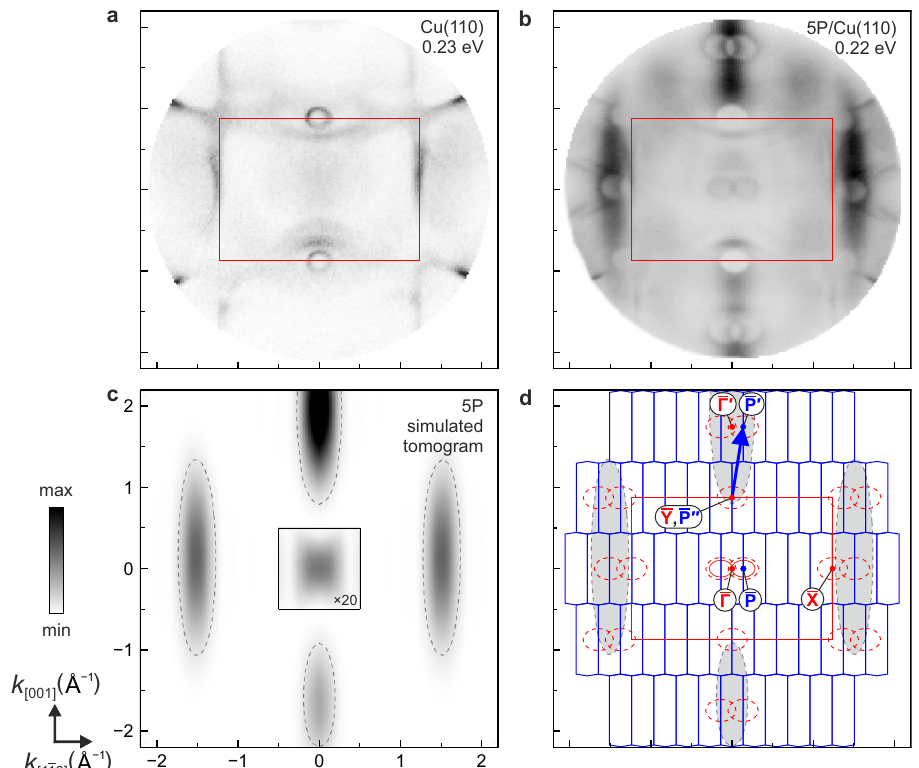
Fig. 2 | Momentum maps of clean Cu(110) and para-quinquephenyl molecules (5P) on Cu(110). a Experimental momentum map of clean Cu(110) at 0.23 eV binding energy. b Experimental momentum map of 5P/Cu(110) at 0.22 eV binding energy. The experimental momentum maps in panels a and b correspond to k ∥ - resolved densities of states. c Theoretically simulated tomogram of free planar 5P. Dashedlinesmarkthemolecularemissionlobes.Withinthemarkedboxcentredat k ∥ =0, the intensity is increased by a factor of 20. d Schematic drawing illustrating the observed features in the experimental momentum map. The red rectangle